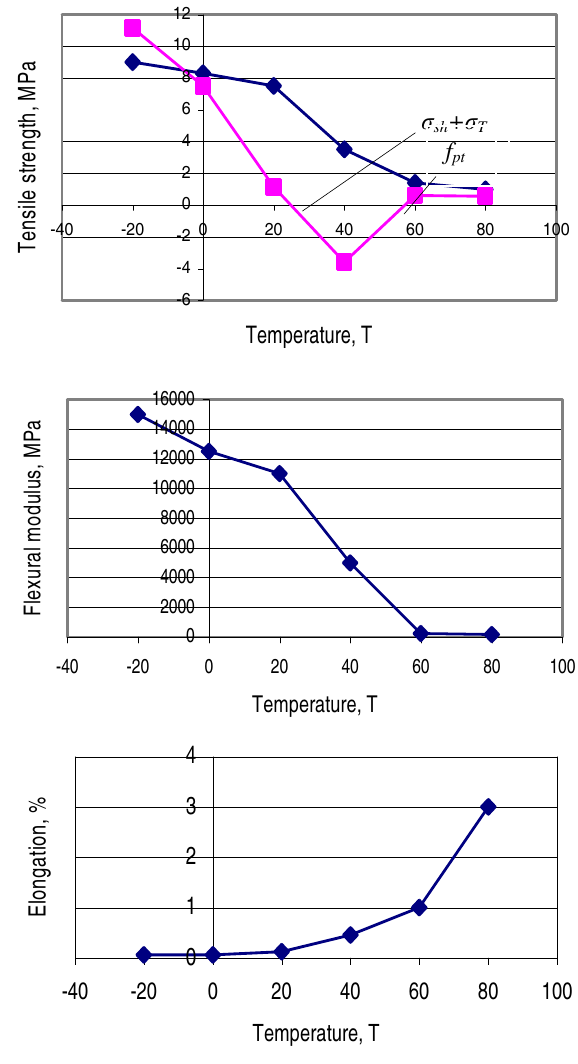
Fig 6. Effect of temperature on mechanical properties of polymer mastic (1:2,25)